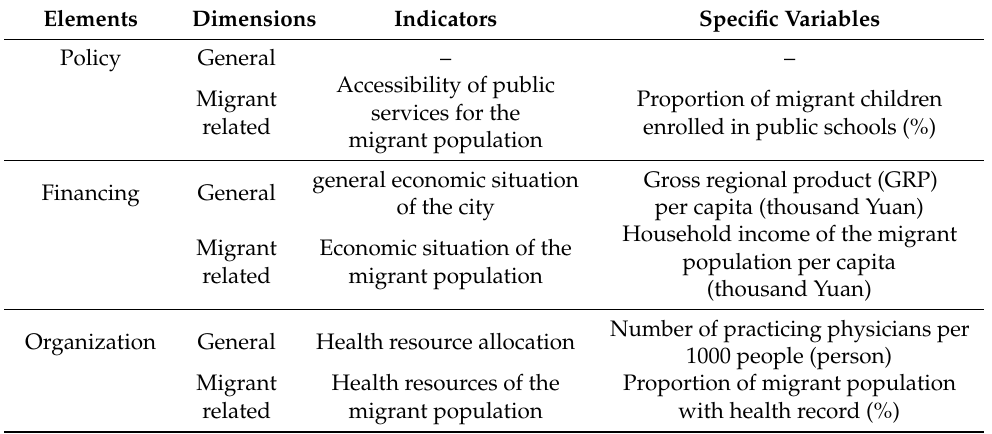
Table 1. Contextual (city-level) variables: Health policy, financing and